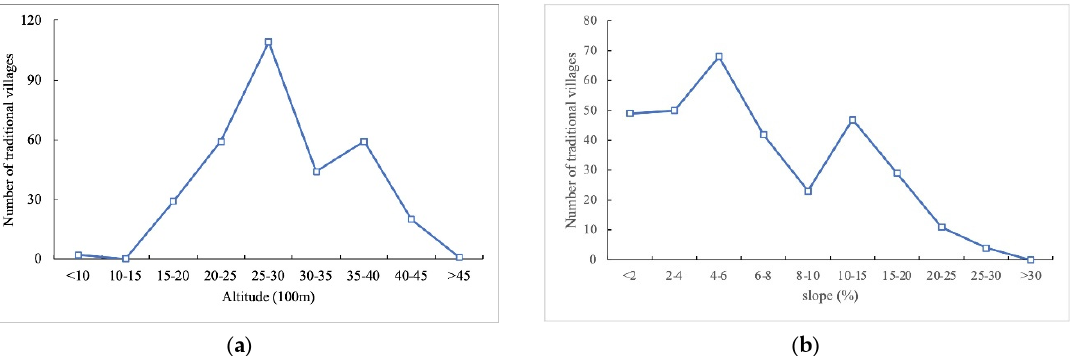
Figure 9. Distribution of traditional villages in terms of altitude and slope on the Tibetan Plateau: ( a ) distribution of villages by altitude; ( b ) distribution of villages by slope angle.